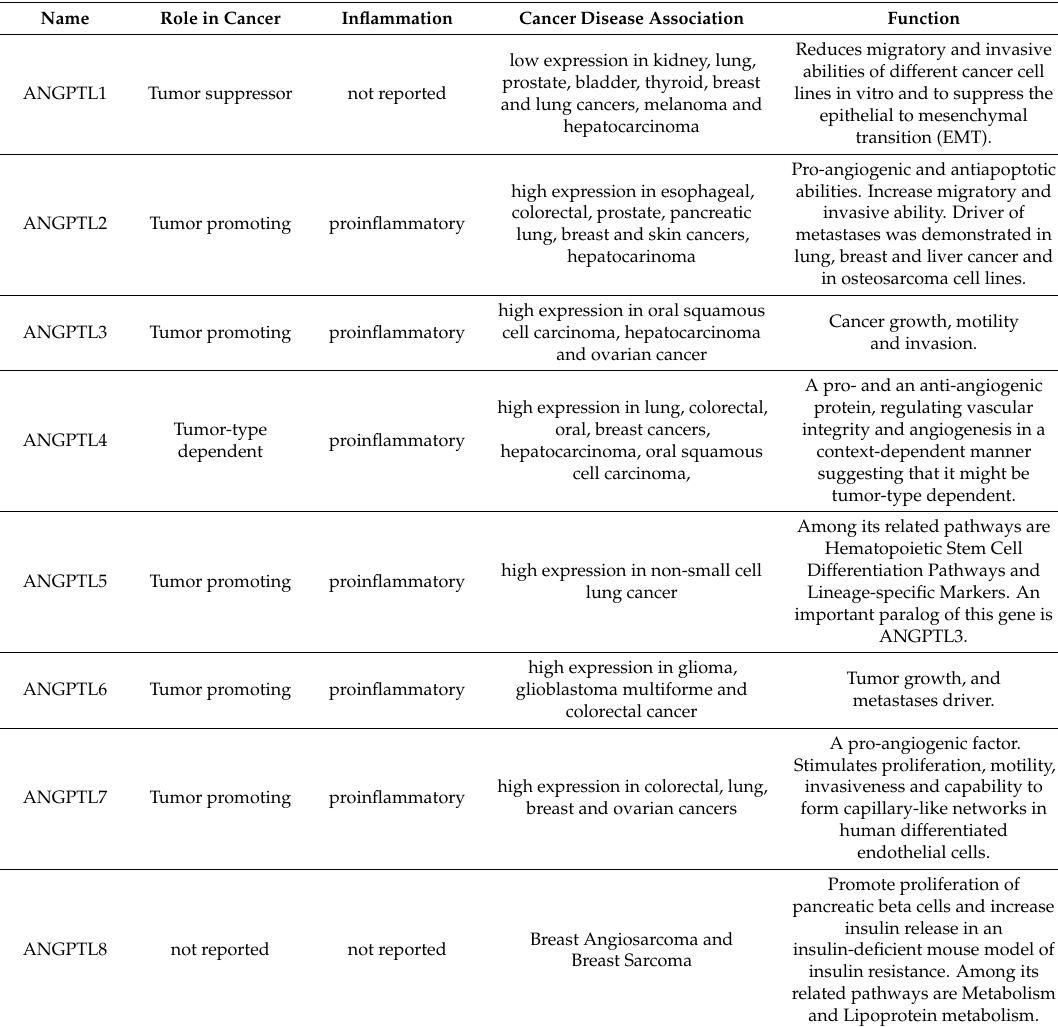
Table 2. ANGPTL proteins in inflammation and